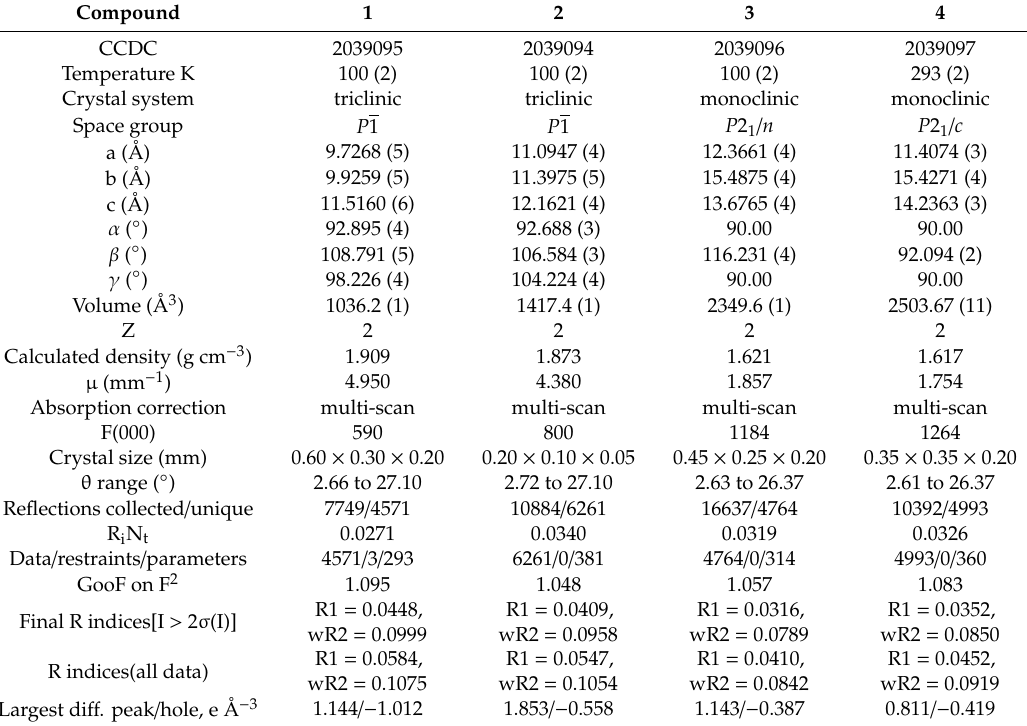
Table 1. Crystal data and structure refinement for complexes